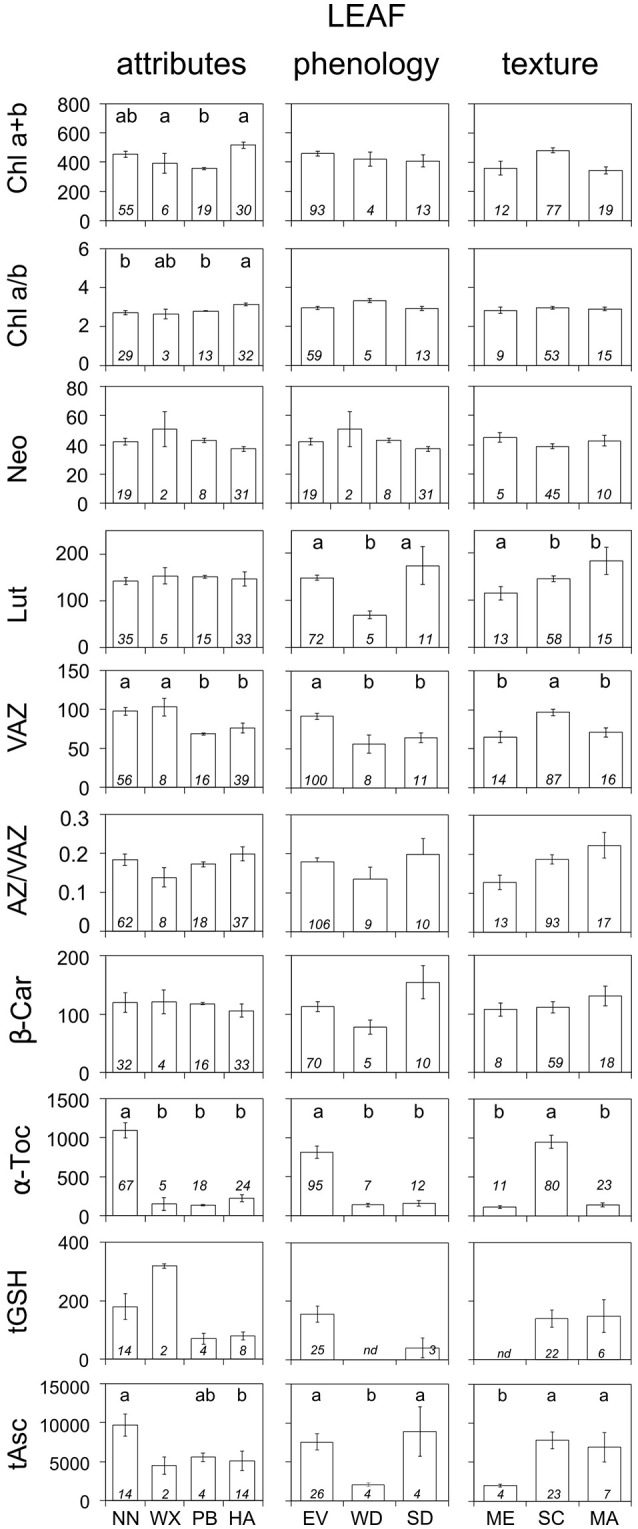
Average composition of photosynthetic pigments and antioxidants according to different leaf traits: attributes, phenology and texture. Units are as in Figure 1. Each bar represents the average ± SE of available data (n, shown inside the bars). Only data for non-stressed plants were included. When significant, differences in the content of pigments or antioxidants among categories inside each panel are depicted with letters above the bars (P < 0.05). “nd” depicts no data available. Abbreviations as in Table 2.